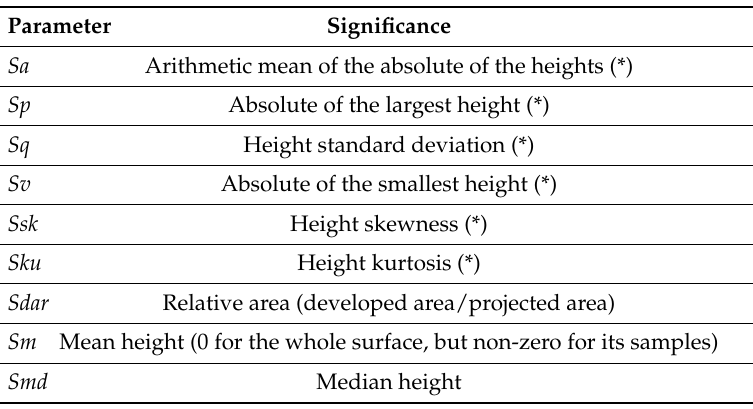
Table 1. Height parameters (* ISO